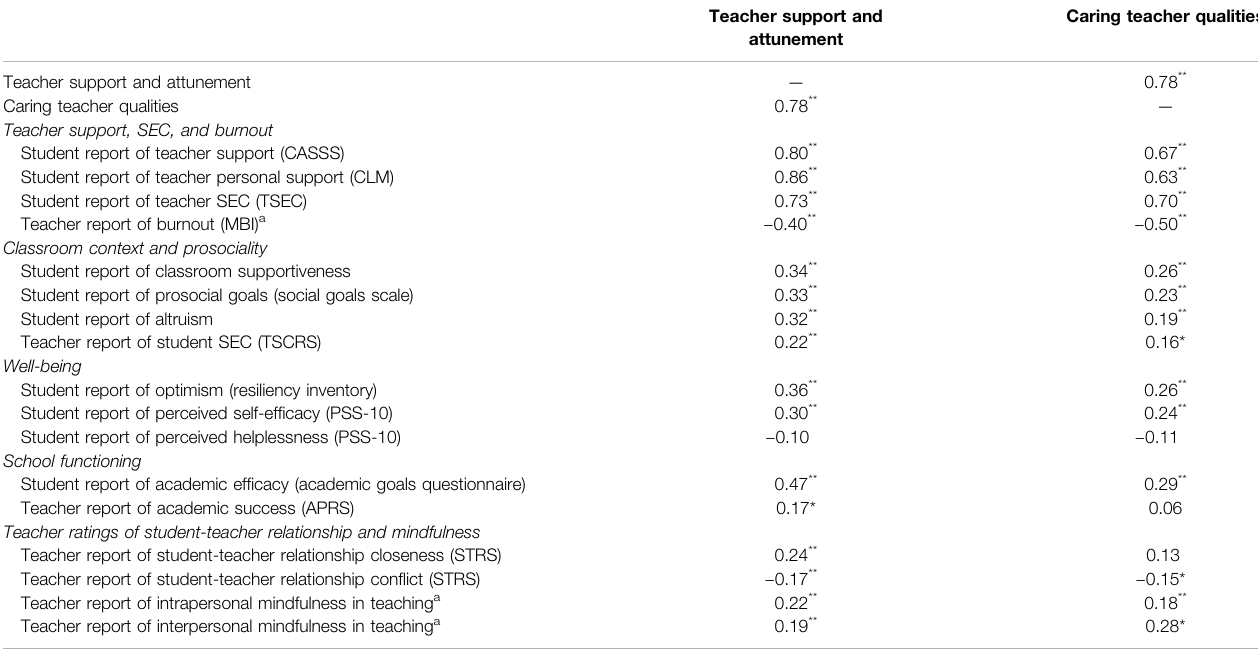
TABLE 6 | Evidence of convergent and discriminant validity of the